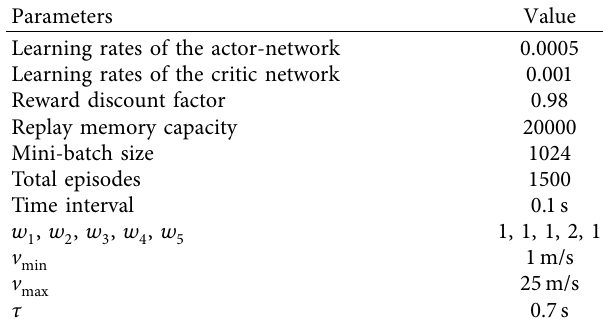
Table 1: Parameters in training experiment.